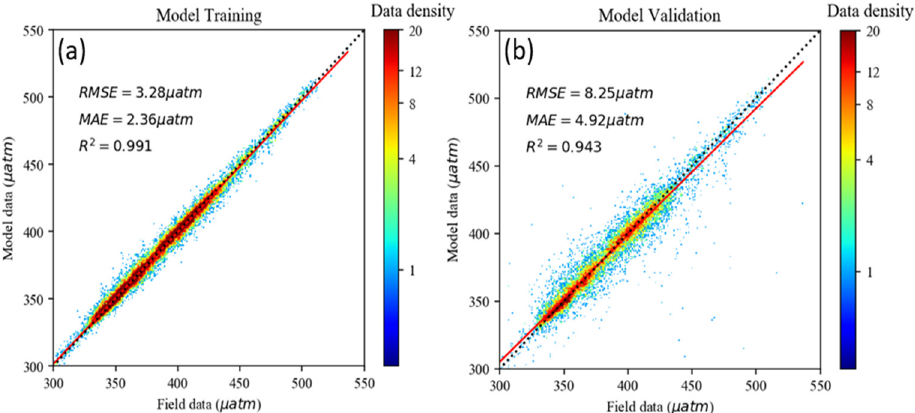
Figure 3. CatBoost model performance in estimating surface pCO 2 in the North Atlantic with ( a ) training set ( b ) validation set.